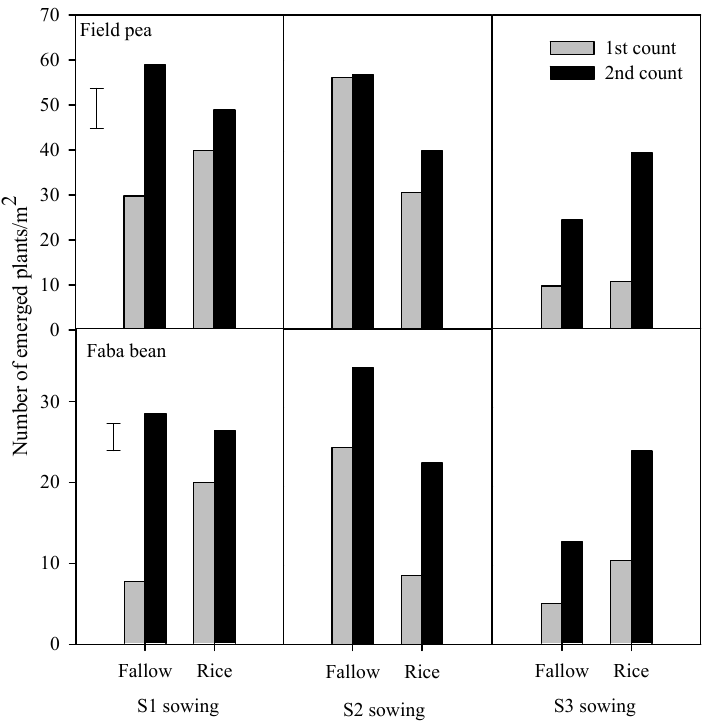
Figure 2. Seedling emergence per square meter for field pea and faba bean in post ‐ fallow and post ‐ rice conditions (fallow and rice, respectively) and at three sowing dates (S1, S2 and S3 sowings, respectively). Seedling counts were taken at one (grey bars) and three (black bars) weeks after sowing for field pea, and two (grey bars) and four (black bars) weeks after sowing for faba bean. Vertical error bars represent Least Significant Difference (LSD) values at the 0.05 level of significance for three sowing dates in both counts.